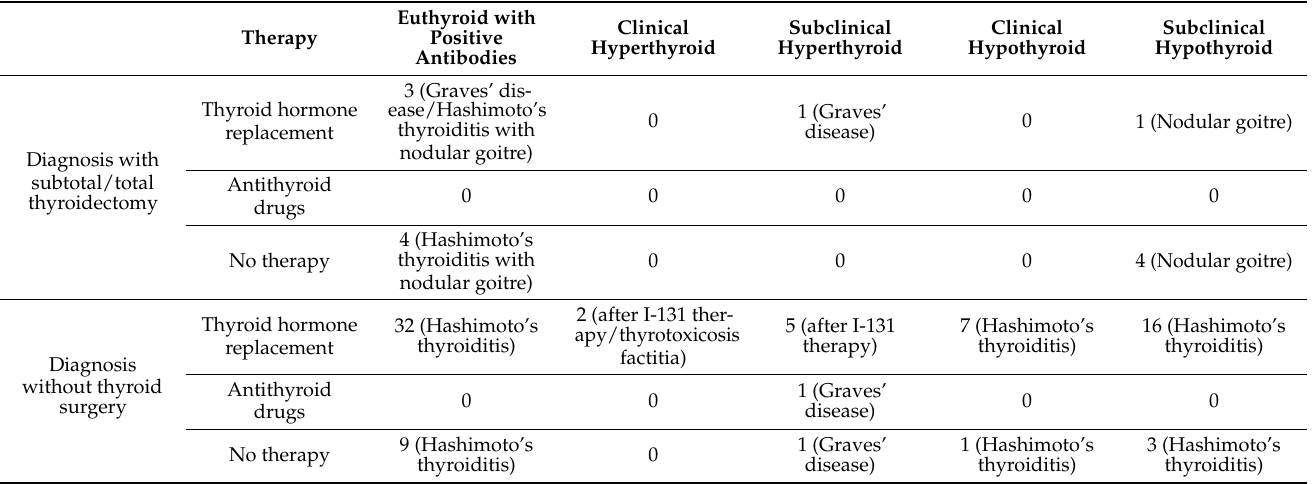
Table 2. Distribution of thyroid therapy intake and clinical thyroid diseases across thyroid function groups and previously established